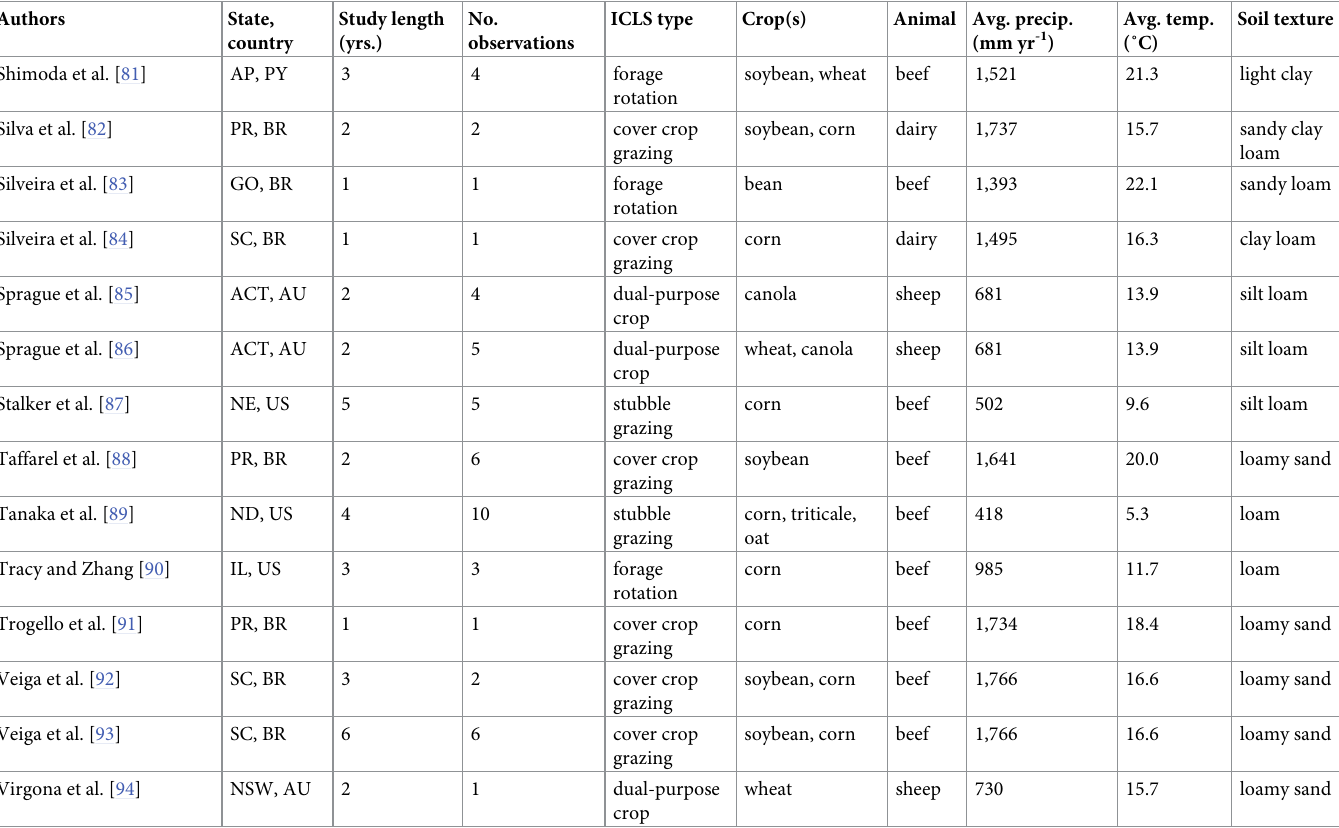
Table 2. Summary of ICLS types and their control systems examined in the meta-analysis.